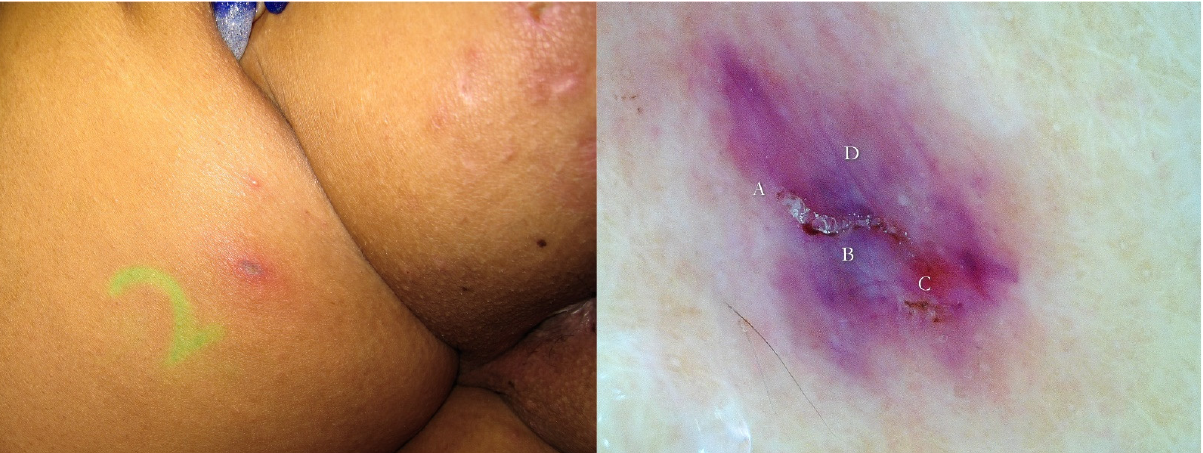
Figure 3. Post ‐ therapy non ‐ specific lesion under buttock after two 5% Permethrin applications 7 days apart ( left ). Under wet dermoscopy, inside erosion, there was an unexpected MGU with the delta sign of Sarcoptes (A) and a gallery with fecal pellets (B) that faded in a fuzzy tail (C). All around, there was a purplish area corresponding to superficial hematoma caused by patient scratching ( right ). A yellow highlighter was used.